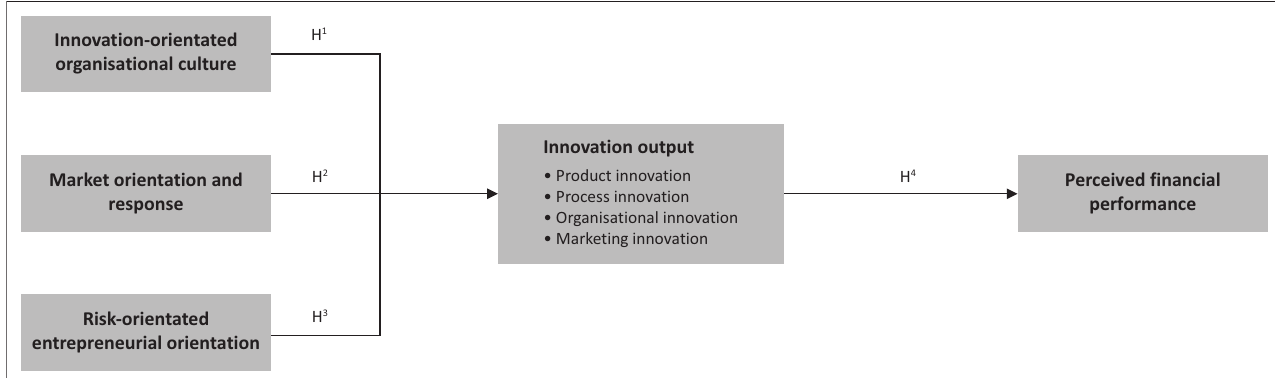
FIGURE 1: Revised hypothesised model: Determinants of Innovation output and its influence on Perceived financial performance.